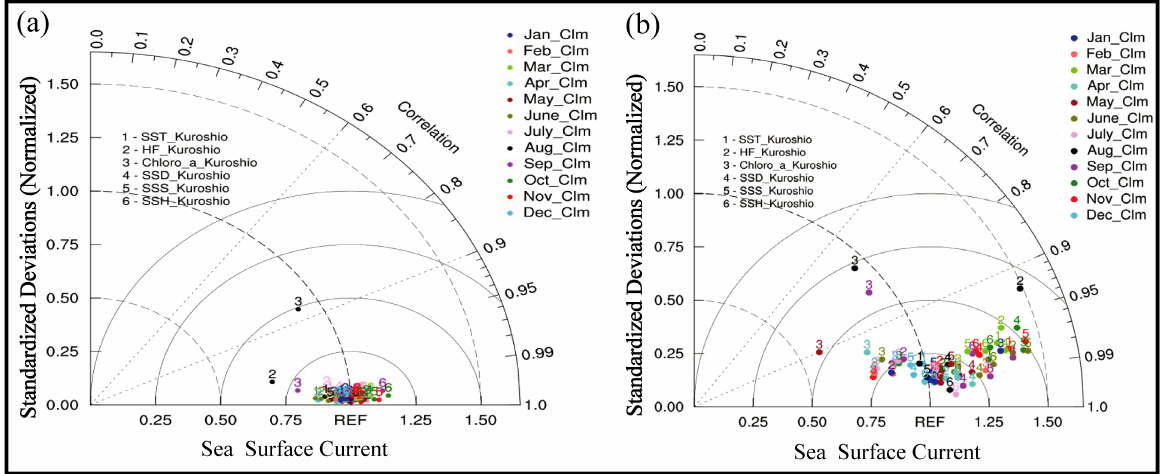
Figure 12. Illustrates the comparison of distance and slope of climatological heat flux (HF), SST, SSS, SSD, chlorophyll- α (CL) and SSH with sea surface current (REF = reference parameter) from their correlation and normalized standard deviations using ( a ) distance correlation; ( b ) slope